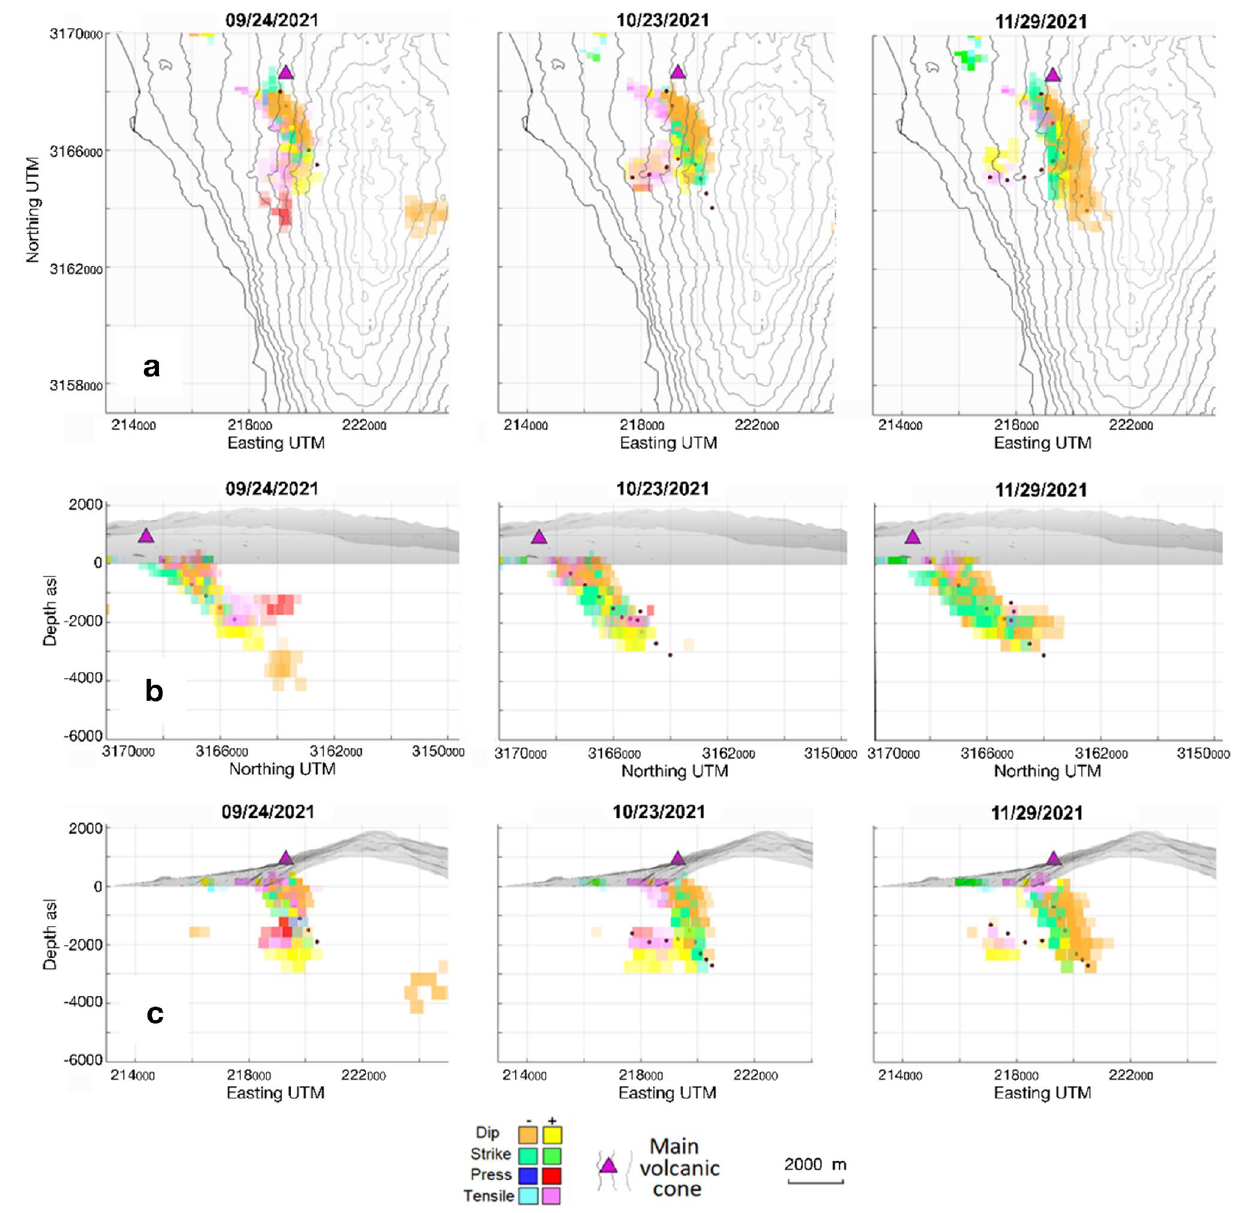
Figure 7. Time evolution of the modeled sources for 09/24/2021–11/29/2021 (2021.73–2021.91). ( a ) Horizontal, ( b ) vertical N-S and ( c ) vertical W-E projections of the sources obtained for diferent epochs in 2021.73–2021.91. The different plots show the time evolution of the different sources obtained from inversion of Sentinel-1 ascending and descending LOS displacement. Purple triangle shows the location of the main volcanic vent during the 2021 La Palma eruption. Red dots indicate the inferred direction of magma flows from deeper areas. The isolated negative dip-slip source which only appear in 09/24/2021 to the East of the vent could be real or an artifact produced by the location to the limit of the study area. But with the information available we can not discriminate between both options. Matlab (www. mathw orks. com) and GMT (www. gener ic- mapin- tools. org) softwares were used to create this figure. This figure complements with Supplementary Movies